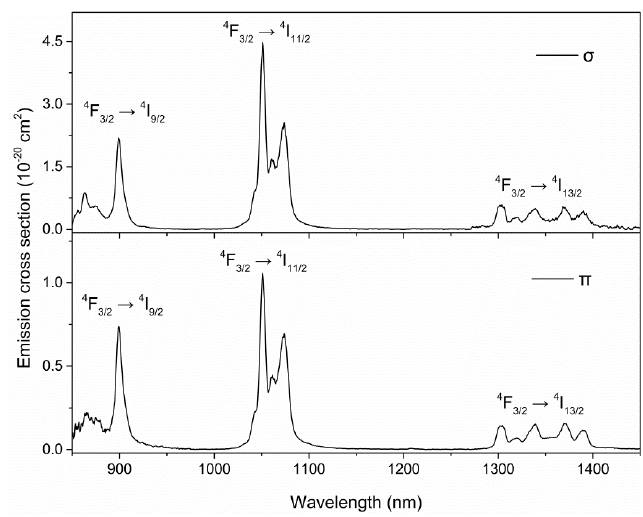
Figure 3. Stimulated emission cross section of Nd:ASL crystal excited by 800 nm at room temperature.